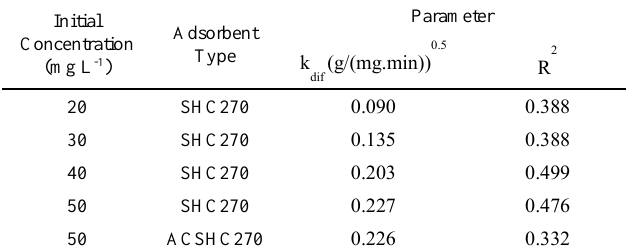
Table 4. Intra-particle diffusion parameter